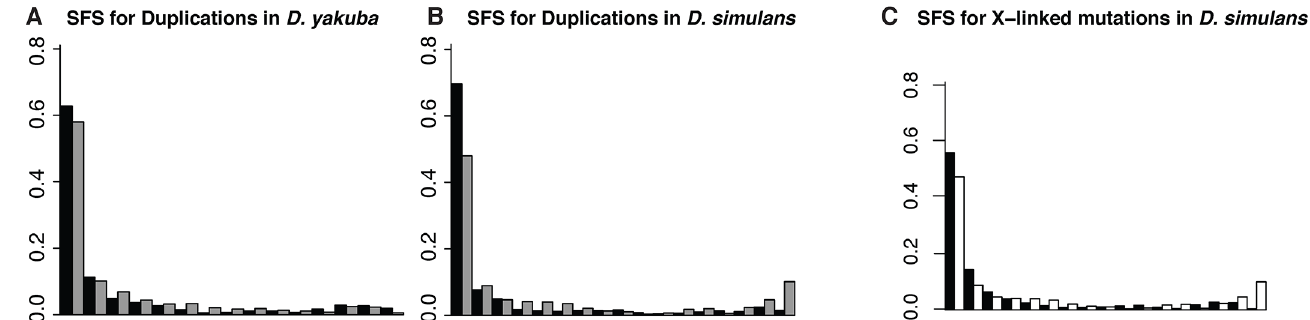
Fig 1. SFS for tandem duplications in D. yakuba and D. simulans , corrected for ascertainment bias. A. Site frequency spectra on the autosomes (black) and on the X (grey) in D. yakuba . B. SFS on the autosomes (black) and on the X (grey) in D. simulans . C. SFS for X-linked intronic SNPs (black) and duplicates (white) in D. simulans . The excess of high frequency variants on the X in D. simulans suggests widespread selection for tandem duplicates on the D. simulans X.